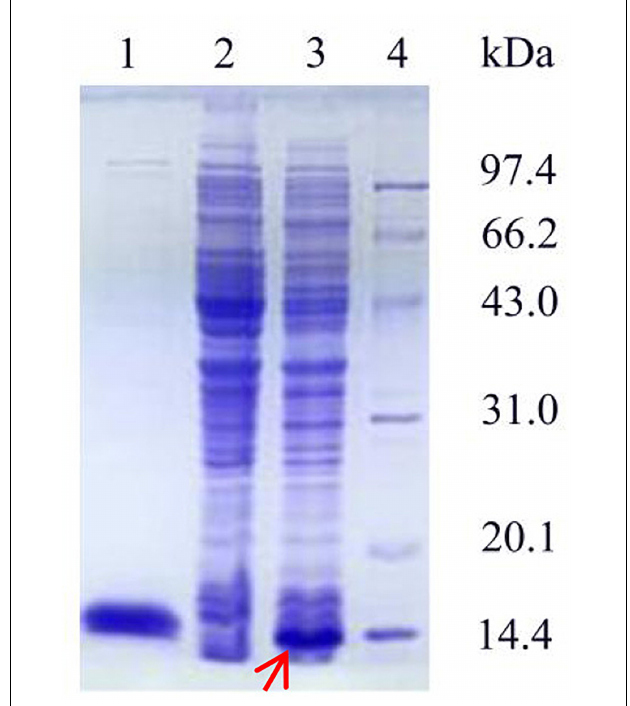
FIGURE 3 | SDS-PAGE analysis of the expression and purification of recombinant Ps-Grx3. Lane 1, purified Ps-Grx3 after Ni-NTA affinity chromatography; lane 2, crude extract from the E. coli BL21/pET-28a( + ); lane 3, crude extract from the E. coli BL21/pET-28a( + )-Ps-Grx3; lane 4, protein TABLE 2 | Comparison of structural adaptation features between Ps-Grx3 and molecular weight marker. EcGrx3. Ps-Grx3